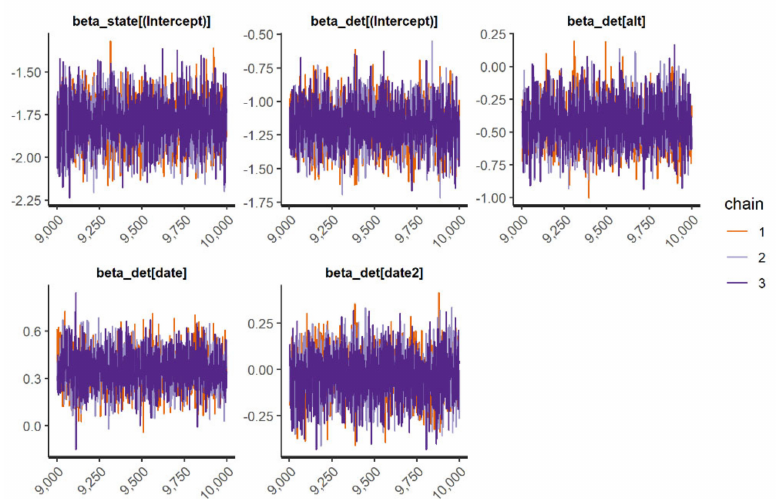
Figure A10. Traceplots from the best occupancy model ( ψ (intercept); ρ (intercept + elevation + date + date2)) of shiny cowbird (Molothrus bonariensis ) in Puerto Rico. Note: alt = elevation; date = Julian date (we considered Julian day 1 as the first day of a device starting to record in the field, which was 1 March 2021); date2 = square of Julian